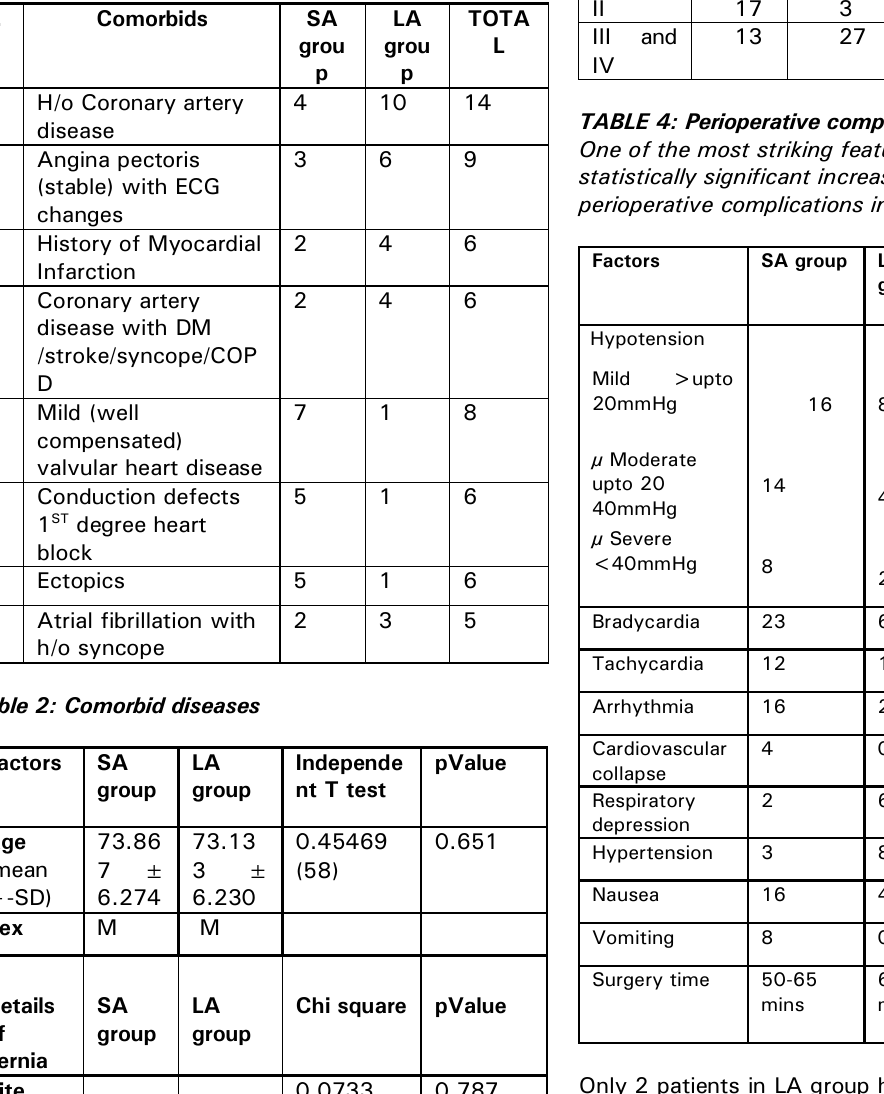
Table 1: Primary data of the study There were no statistical significant differences (p values) in age and location of hernia. But there is a significant statistical difference between the 2groups regarding the type of hernia. (Table 1)